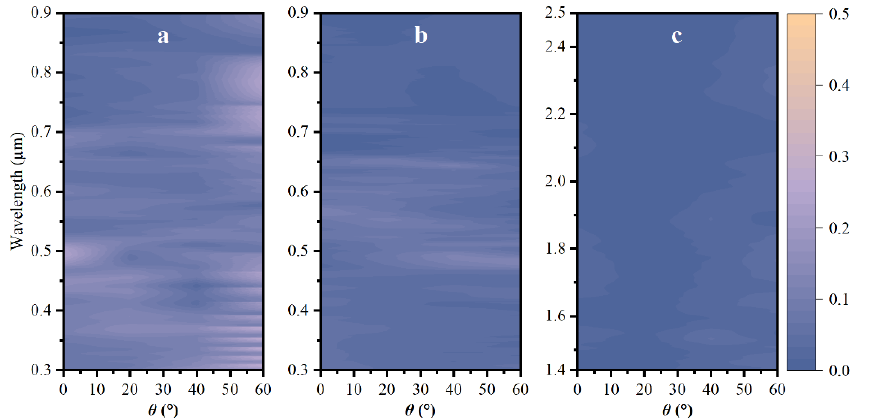
Figure 8. Reflectance spectra for ( a ) the 5 µm nanoripple-cone and ( b ) the 20 µm nanoripple-cone over the incident angle from 0° to 60° as a function of wavelength from 0.3 – 0.9 µm, as well ( c ) for the 20 µm nanoripple-cone in the NIR region.